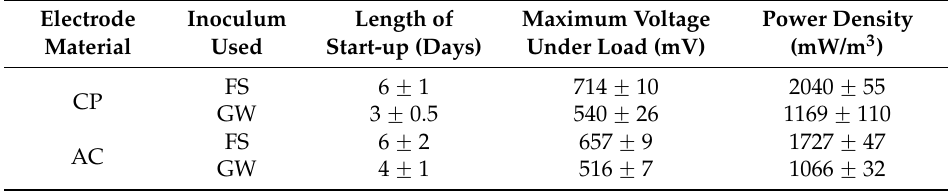
Table 5. Comparison of palm kernel shell AC and CP electrode performance obtained in the MFCs.